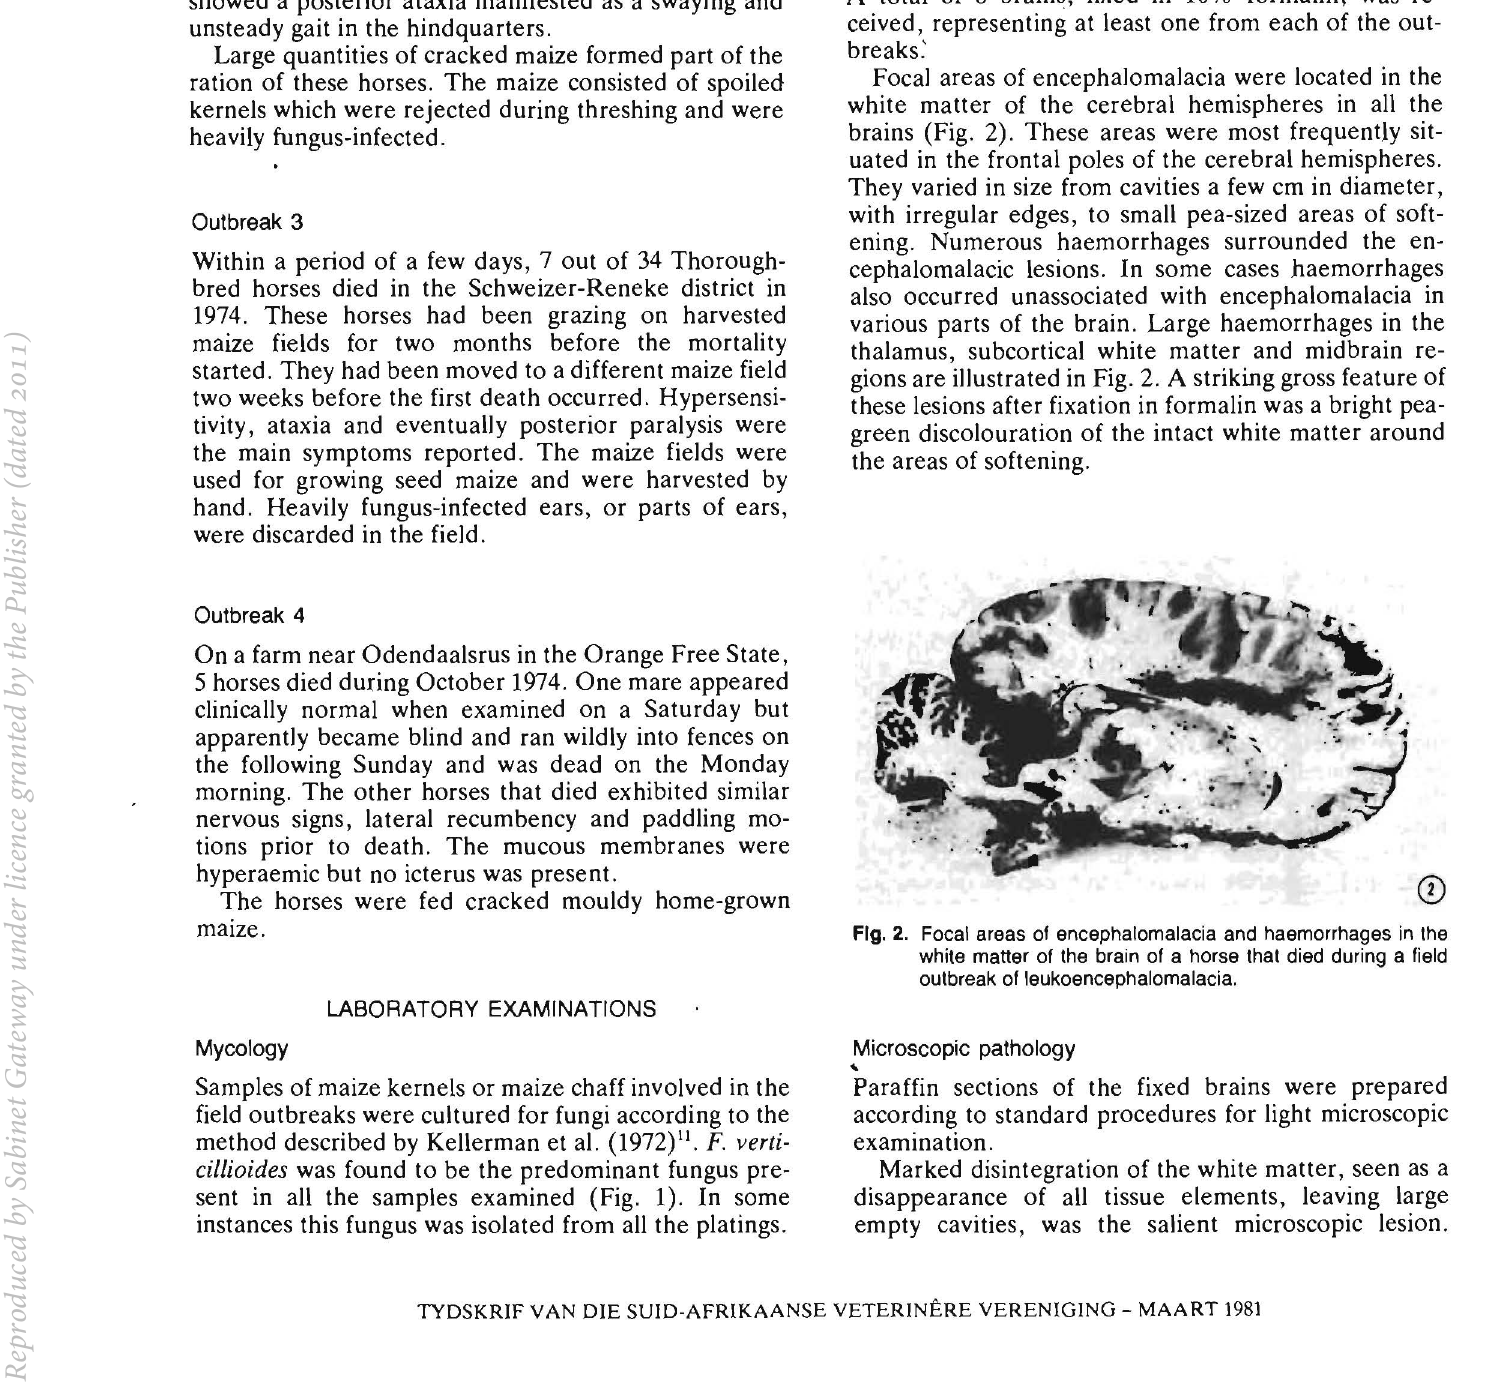
Fig. 1. Mouldy maize ears associated with a field outbreak of equine leukoencephalomalacia. The ears are insect-damaged and heavily infected by Fusarium verticil/ioides.